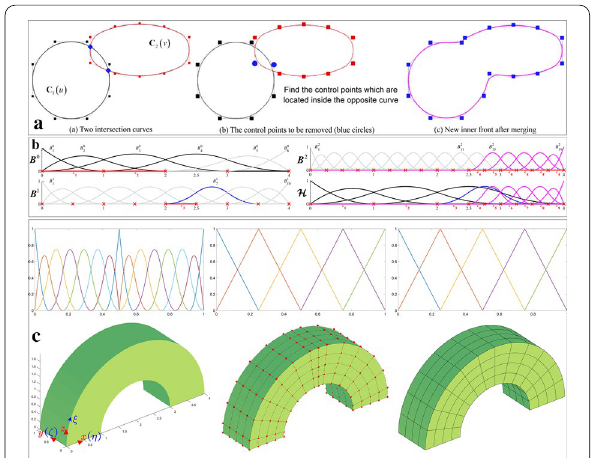
Figure 11 Illustrations of different spline